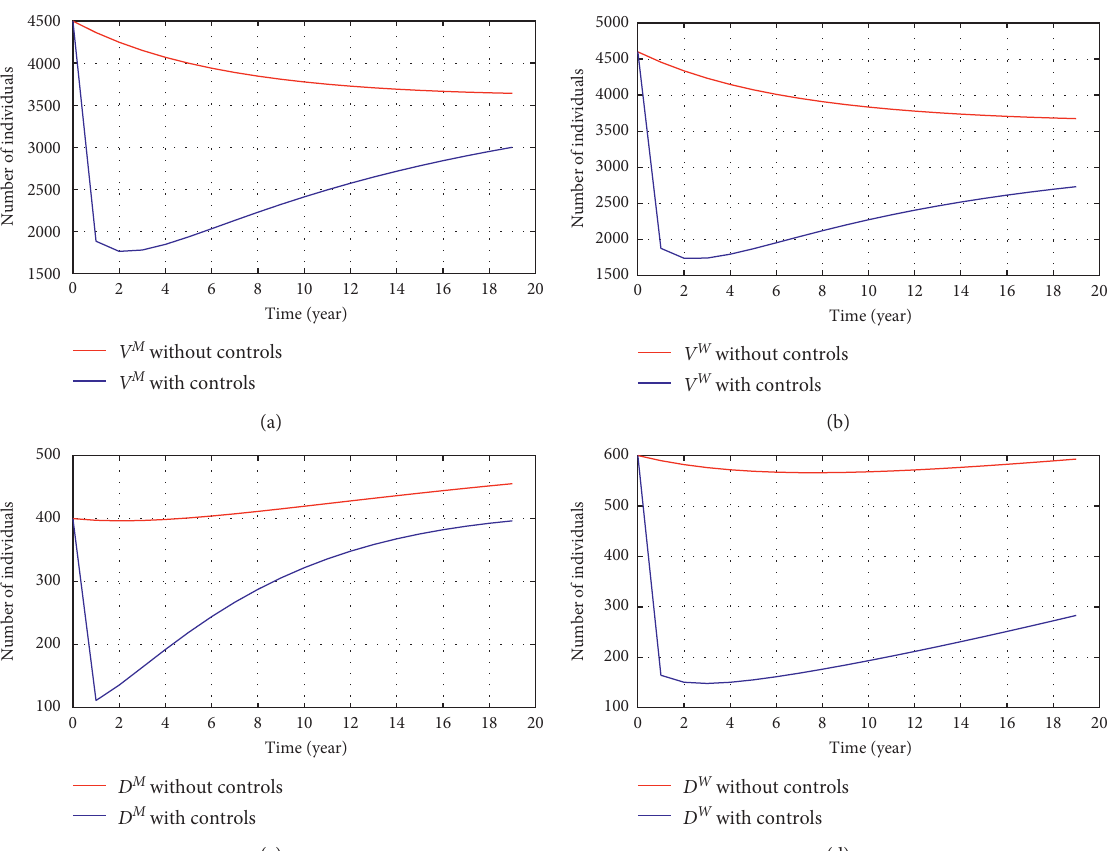
Figure 3: Time evolution of virgin and divorced populations with and without